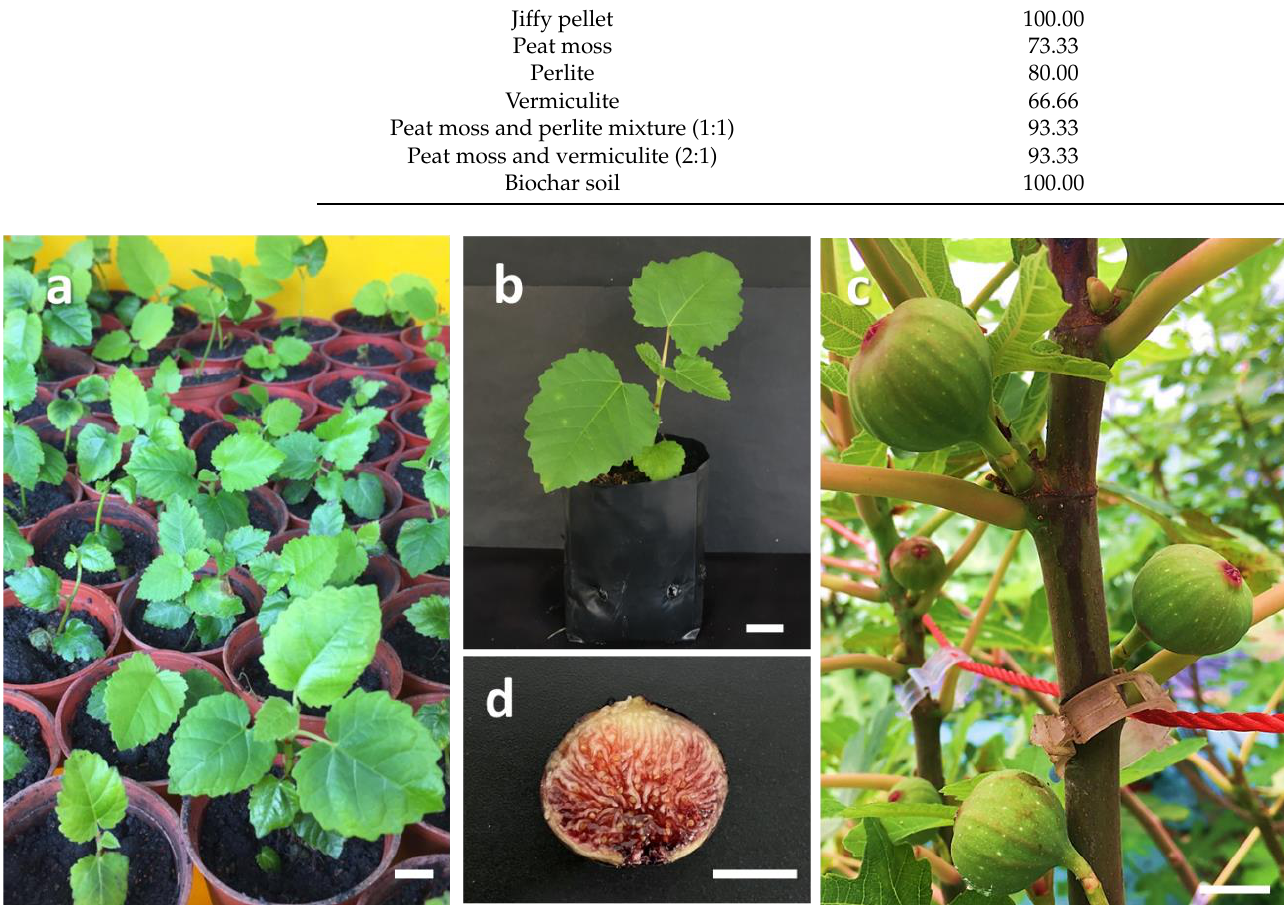
Figure 2. Ex vitro plantlets and fruits of Ficus carica cv. “Violette de Solliès”: ( a ) acclimatized plants in biochar soil after 2 weeks (scale bar = 1 cm); ( b ) acclimatized plants in polybags after 8 weeks (scale bar = 5 cm); ( c ) acclimatized plants grown in commercial greenhouse (scale bar = 2 cm); ( d ) fruit produced from tissue-cultured plants 10 months after acclimatization (scale bar = 1 cm).